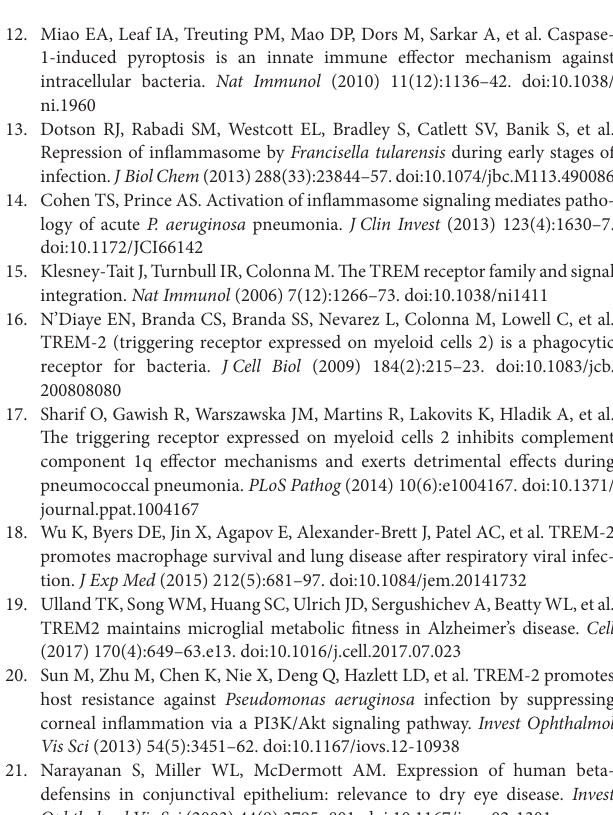
FigUre s1 | (a) mRNA expression level of caspase-1 was examined by real-time PCR in heat-killed Pseudomonas aeruginosa (HK-PA) treated wild type (WT) and Trem2 − / − B6 corneas at 5 days after treatment and WT and Trem2 − / − BMDM which were treated with HK-PA at MOI of 5 for 6 h. (B) The protein level of caspase-11 in P. aeruginosa -infected WT and Trem2 − / − B6 corneas were detected with western blot at 1 and 5 days after infection. (c) A6(1) cells were transfected with TREM2 siRNA versus control scrambled siRNA, followed by HK-PA treatment at MOI of 5 for 6 h. mRNA expression levels of TREM2, IL-1 β , IL-18, MIP-2, and caspase-1 was examined by real-time PCR. Data were the mean ± SEM and represent three individual experiments. * P <